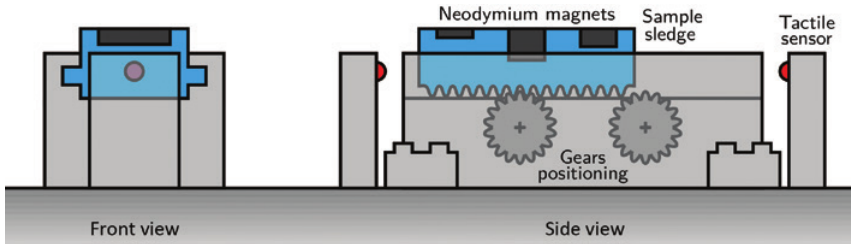
Figure 5: Sketch of sample unit in front and side view of the macroscopic MFM model.